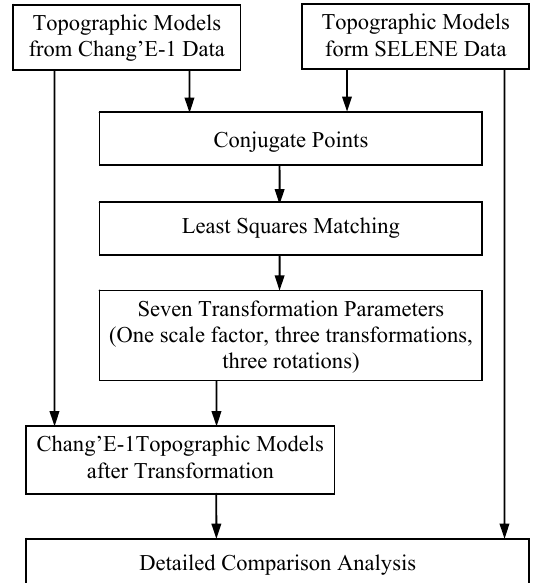
Figure 1. Framework of the least square adjustment approach for the Chang’E-1 and SELENE laser altimeter